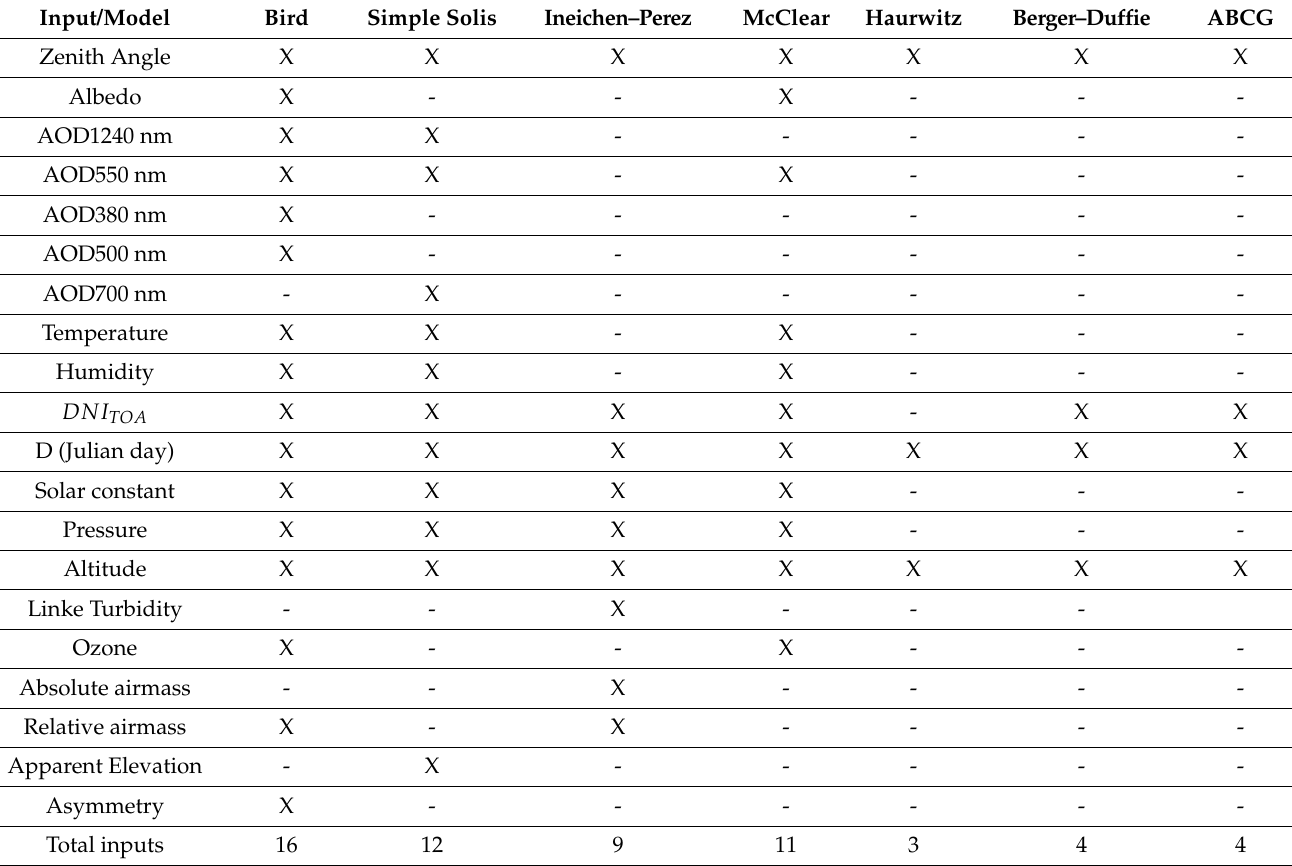
Table 3. A table summarising different inputs required by different